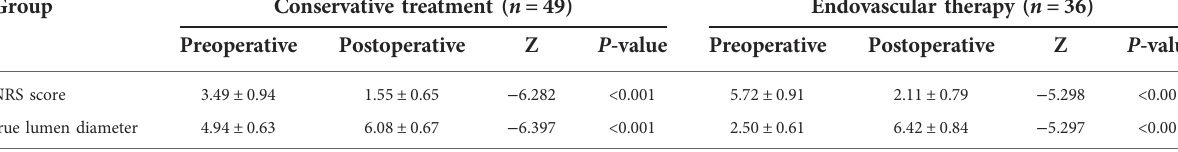
TABLE 4 Comparison of curative effect indexes before and after treatment in the two groups. Group